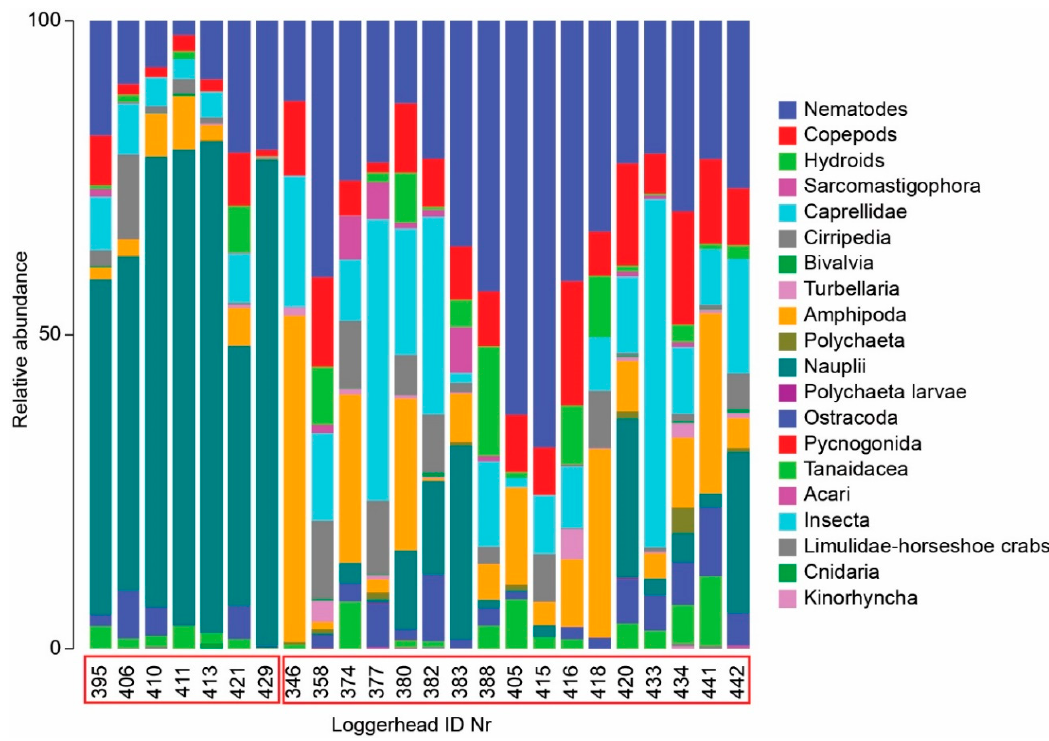
Figure 4. Relative abundance of meiofauna higher taxa for each turtle carapace. Red boxes indicate the significant cluster groups (SIMPROF analysis using 5% significance test).